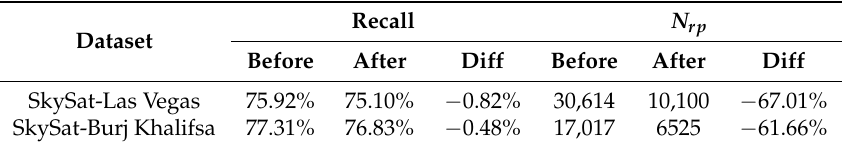
Table 2. Evaluation on the effectiveness of